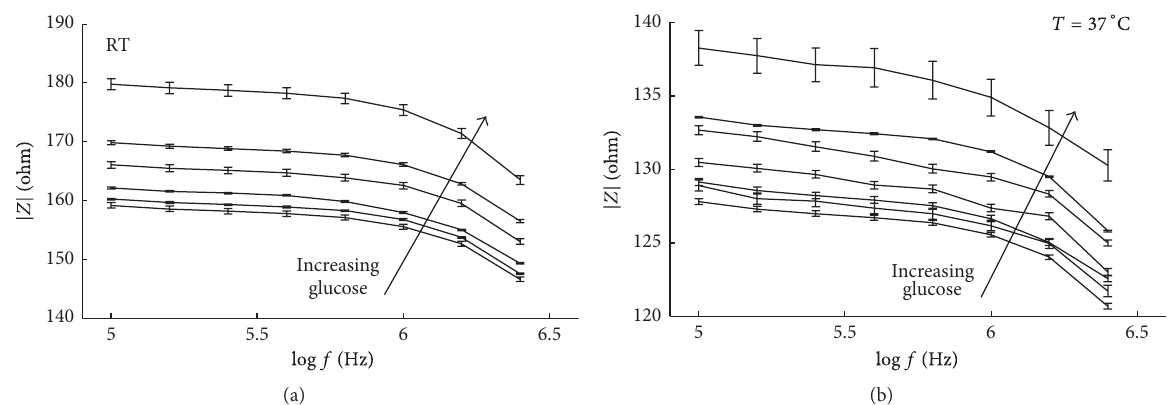
F 3: Impedance modulus of samples of physiological solution alone and with added glucose at concentrations from 5000 to nearly 78mg/dL, at room temperature (a) and at 37